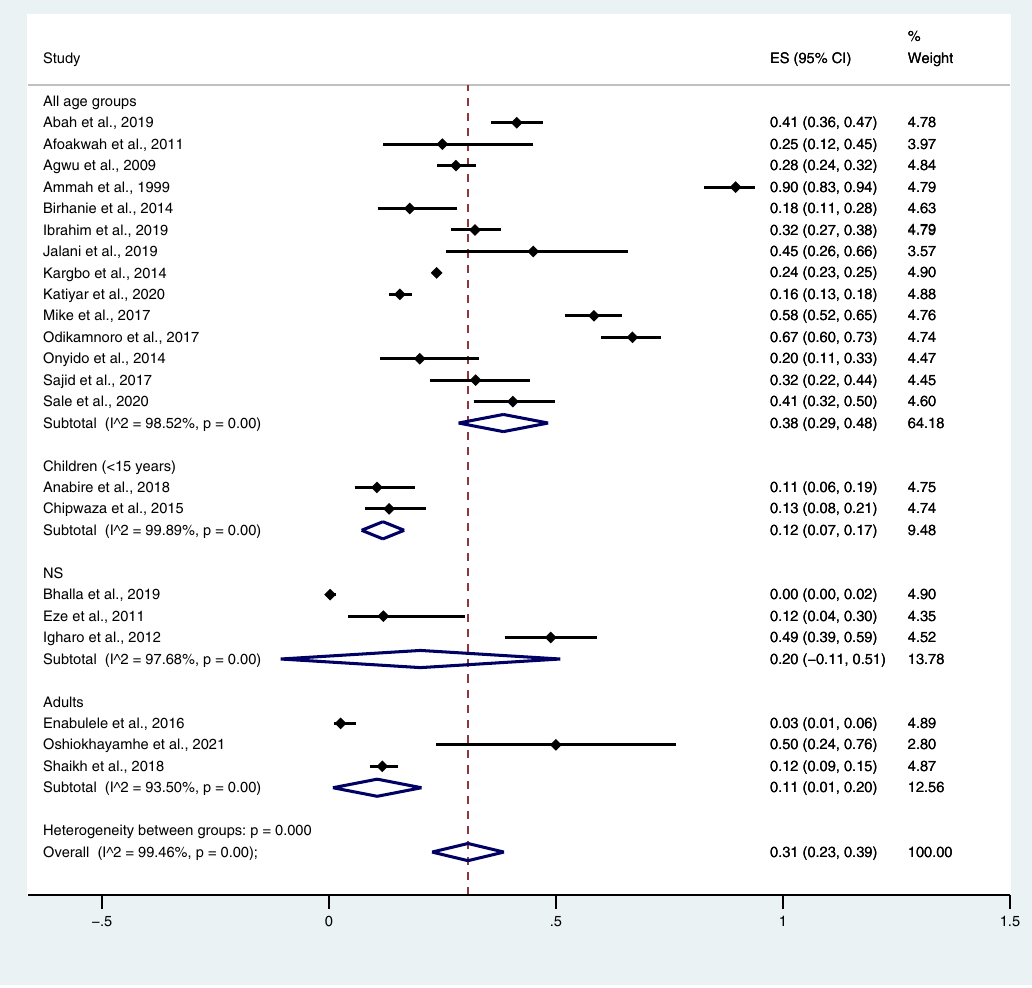
Figure 14. Prevalence of typhoidal/NTS infection among patients with malaria using the Widal test for the identification of Salmonella spp. infection stratified by age groups. ES proportion estimate (multiply 100 units for interpreted as prevalence estimate), CI confidence interval, NS not